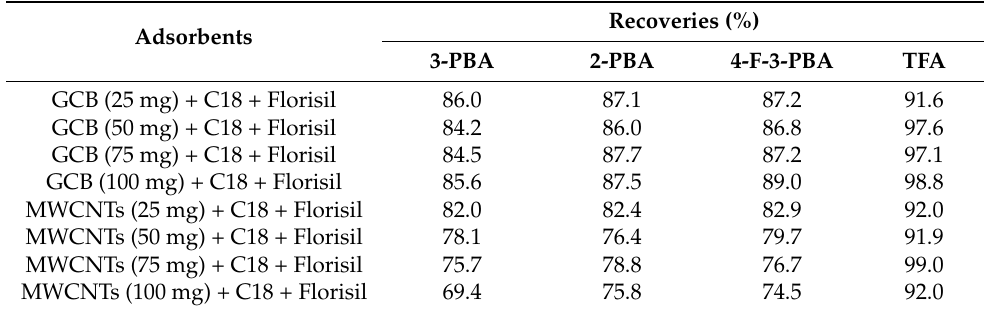
Table 3. The effect of different amounts of GCB and MWCNTs combined with 200 mg C18 and 200 mg florisil on the recovery of analytes.